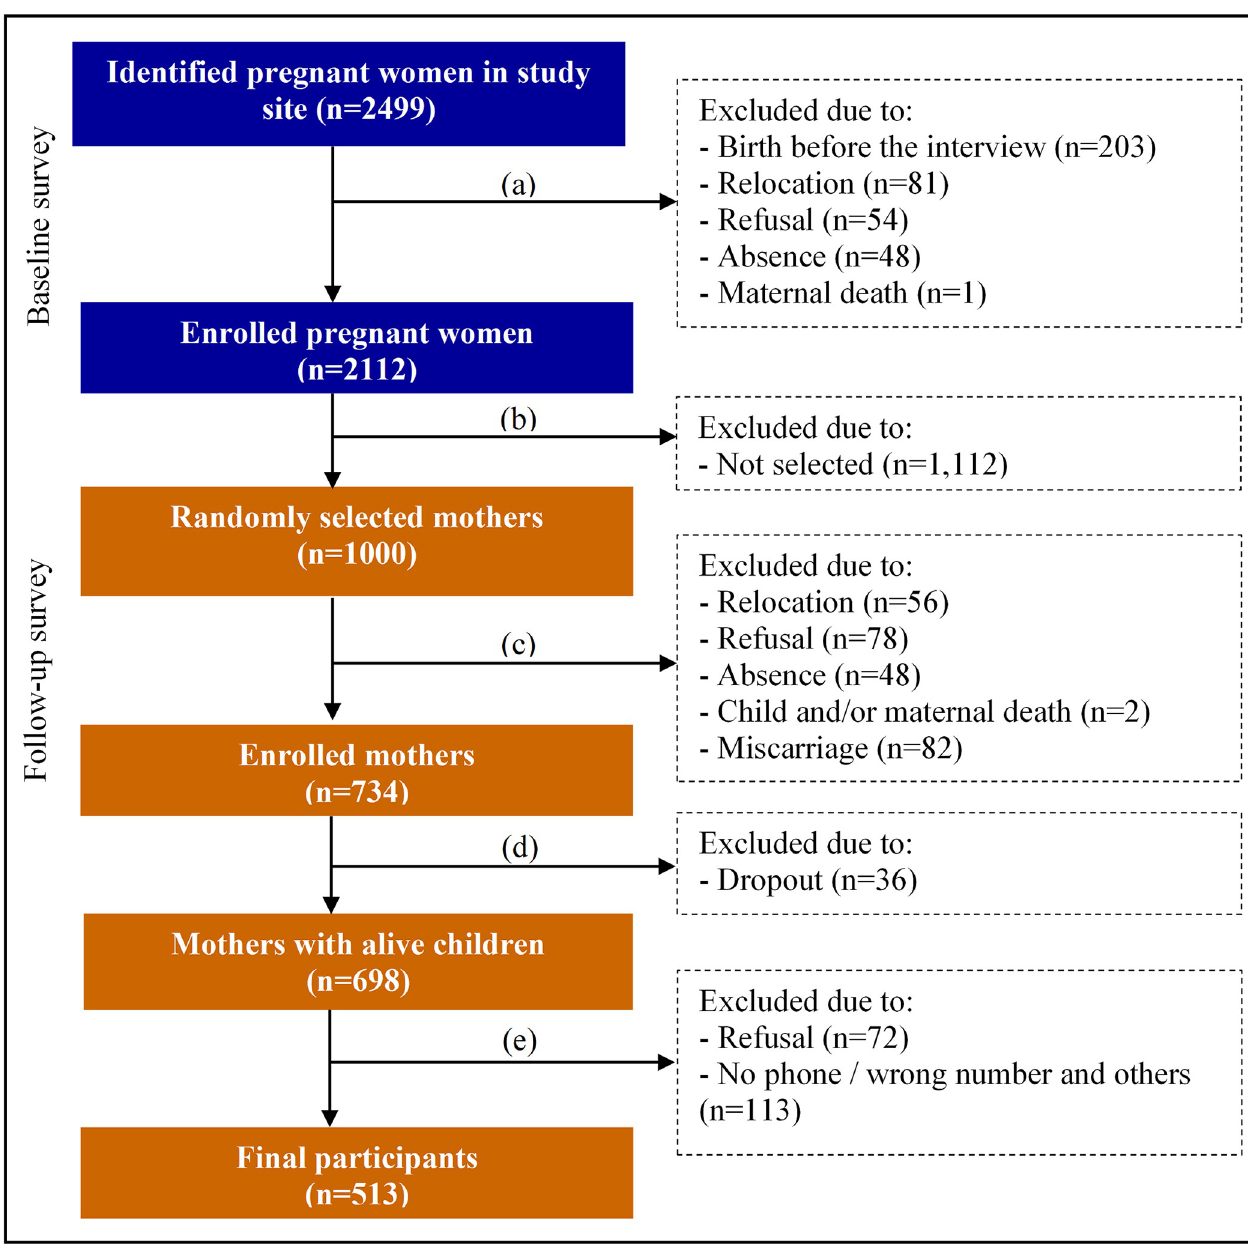
Fig 1. Flow of the sampling